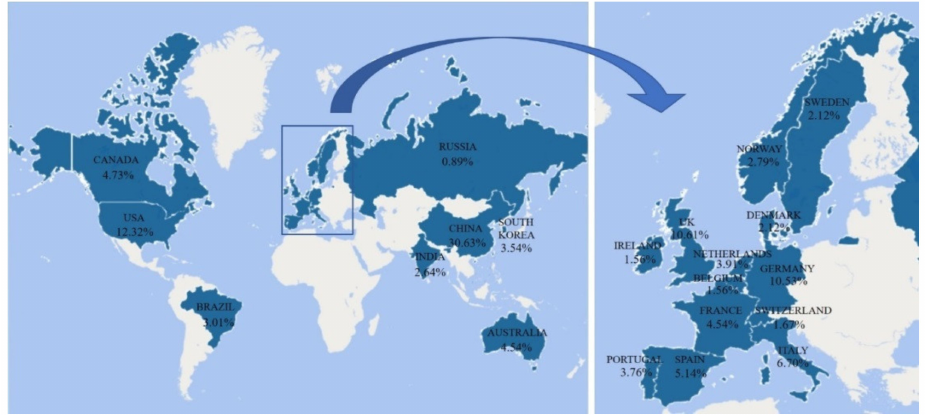
Figure 1. Distribution of microplastics studies at different countries around the world (based on Web of Science